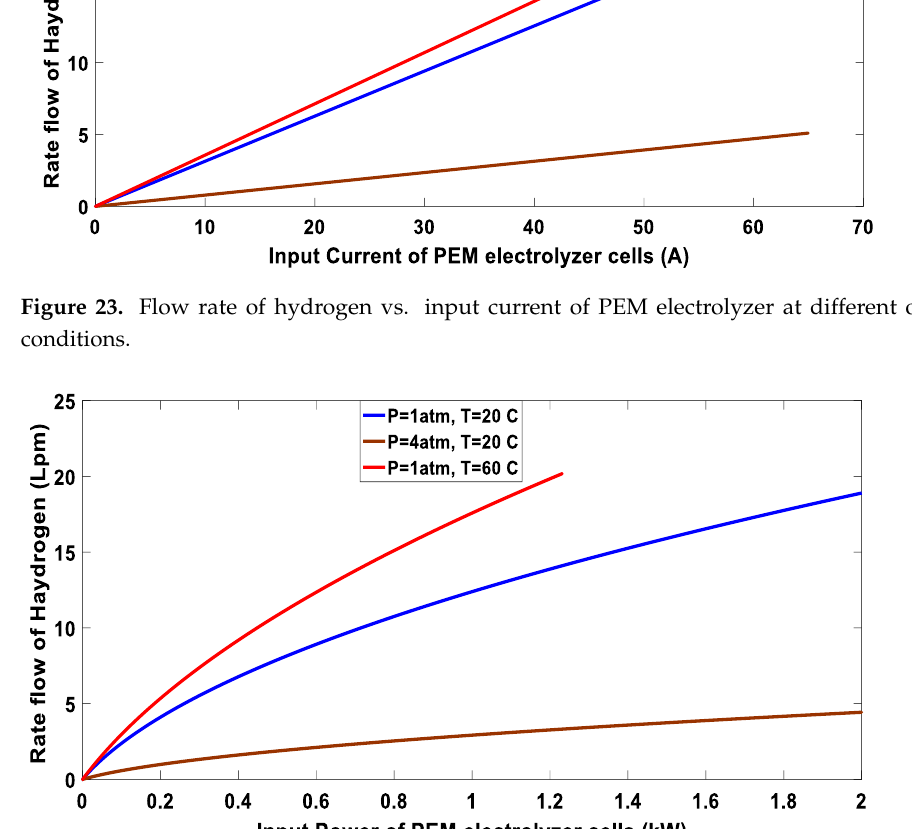
Figure 24. Flow rate of hydrogen vs. input power of PEM electrolyzer at different operating condi- tions.